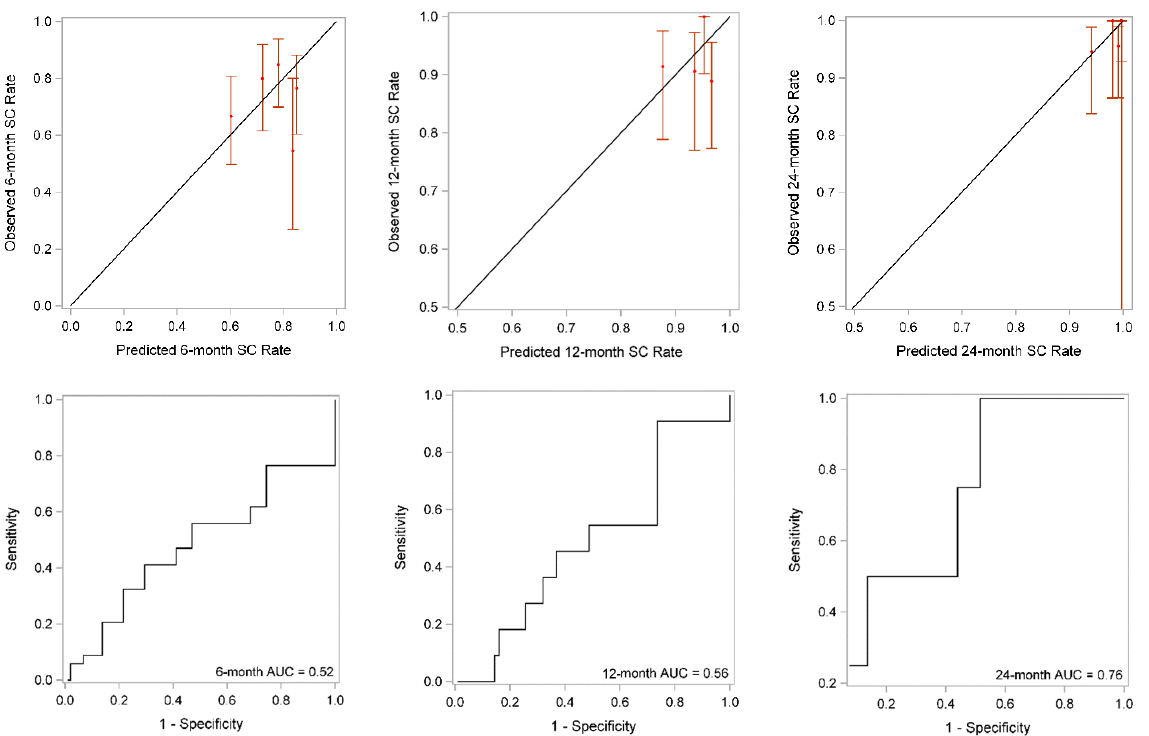
Figure 5. Calibration plots ( upper panels ) and receiver operating curves (ROC) ( lower panels ) that showed initial model performance at 6, 12, and 24 months. SC = social continence; AUC = area under the curve.